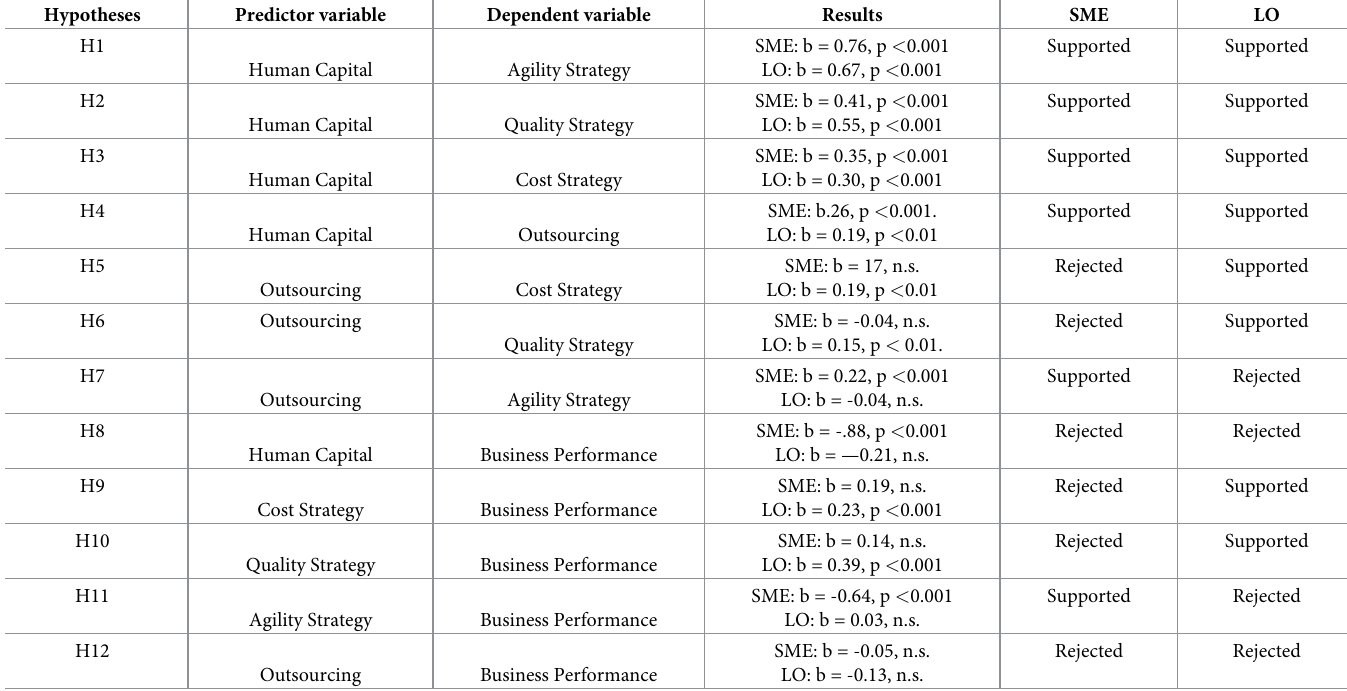
Table 6. Hypothesis